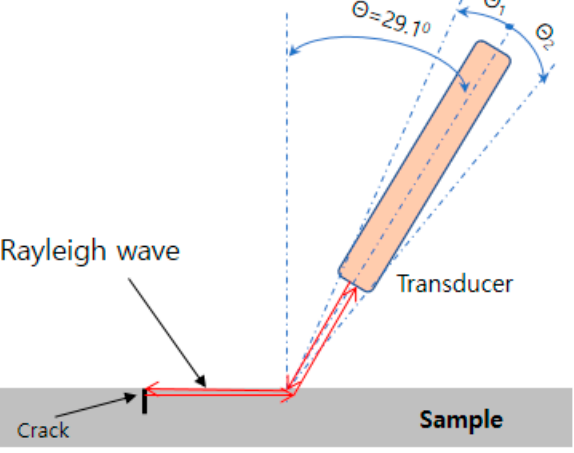
Figure 8. A method to determine the Rayleigh angle on a piston rod with a crack.